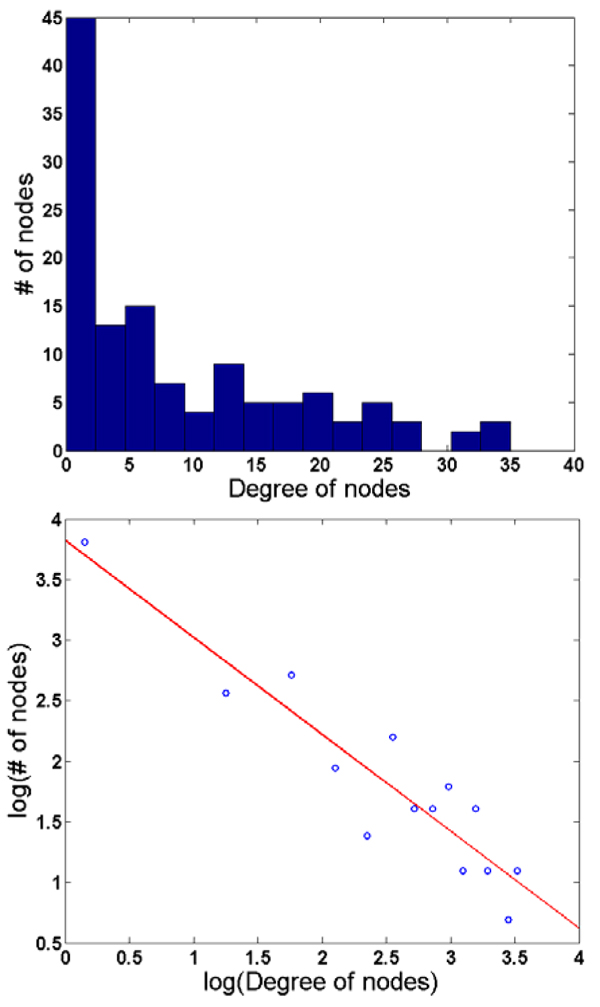
Top: Histogram of the number of nodes in the clinical attribute network created during Phase 1c. Bottom: Using a log-log scale, the histogram can be fitted by a straight line (red, R=0.93).